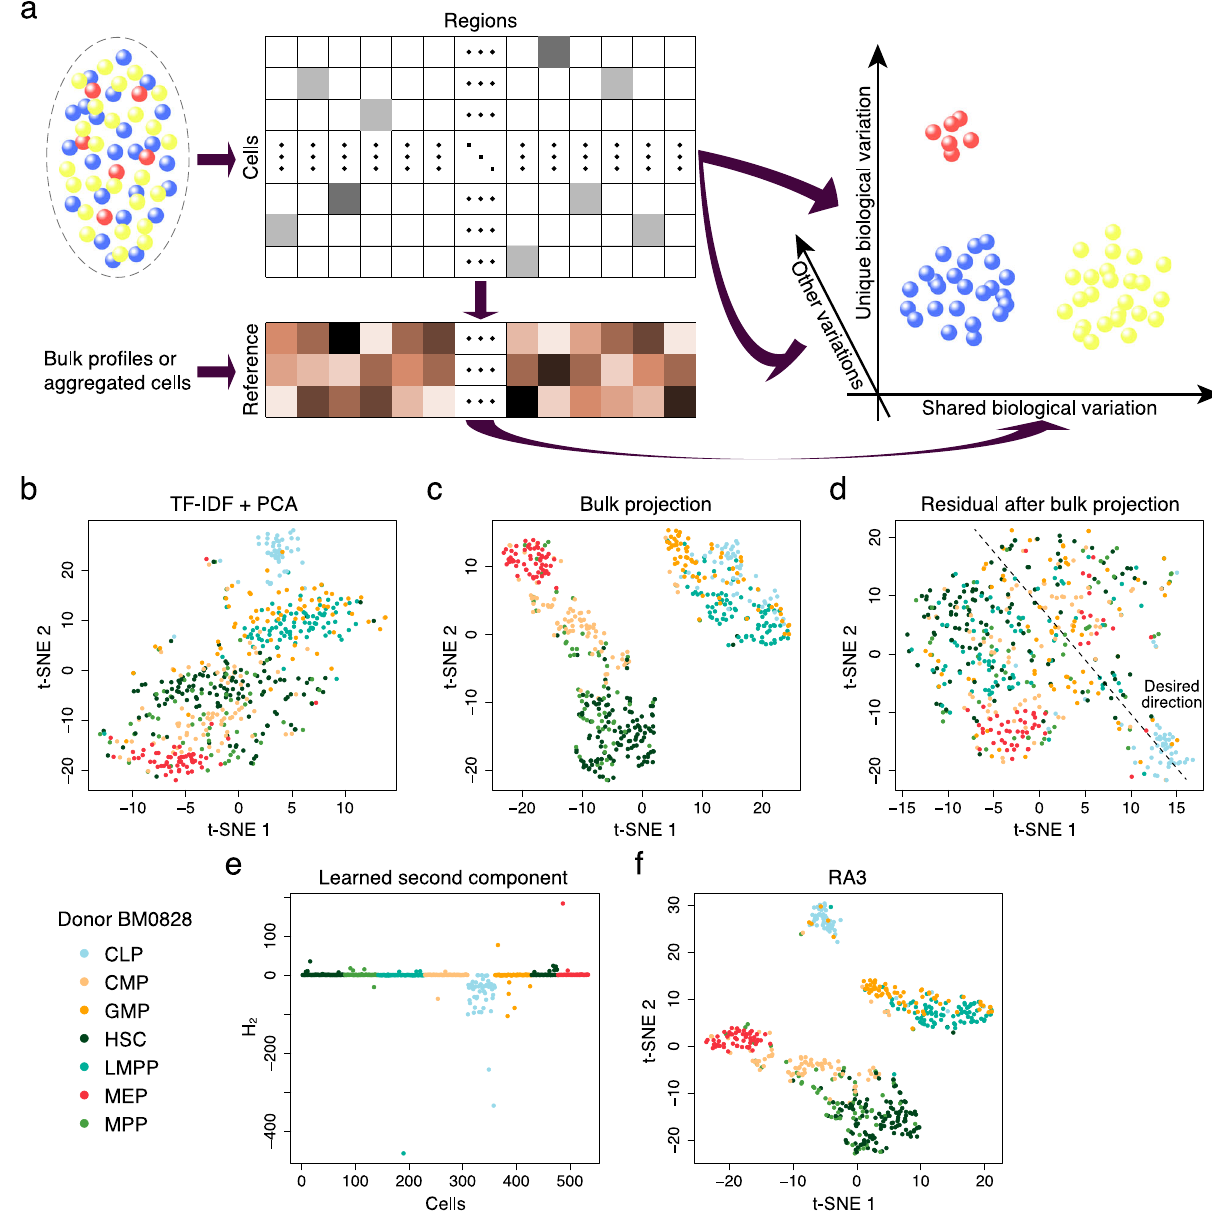
Fig. 1 The reference-guided approach for the analysis of scCAS data. a A graphical illustration of the RA3 model. RA3 decomposes the variation in scCAS data into three components: the component that captures the shared biological variation with reference data, the component that captures the unique biological variation in single-cell data, and the component that captures other variations. b t-SNE visualization of the cells from donor BM0828 using latent features obtained from TF-IDF + PCA. c t-SNE visualization of the cells from donor BM0828 using latent features obtained from bulk projection. d We calculated the residuals after the bulk projection. PCA was performed on the residuals, followed by t-SNE visualization. e The learned second component with the spike-and-slab prior in RA3. f t-SNE visualization using the fi rst two components learned by RA3. TF-IDF term frequency-inverse document frequency transformation, PCA principal component